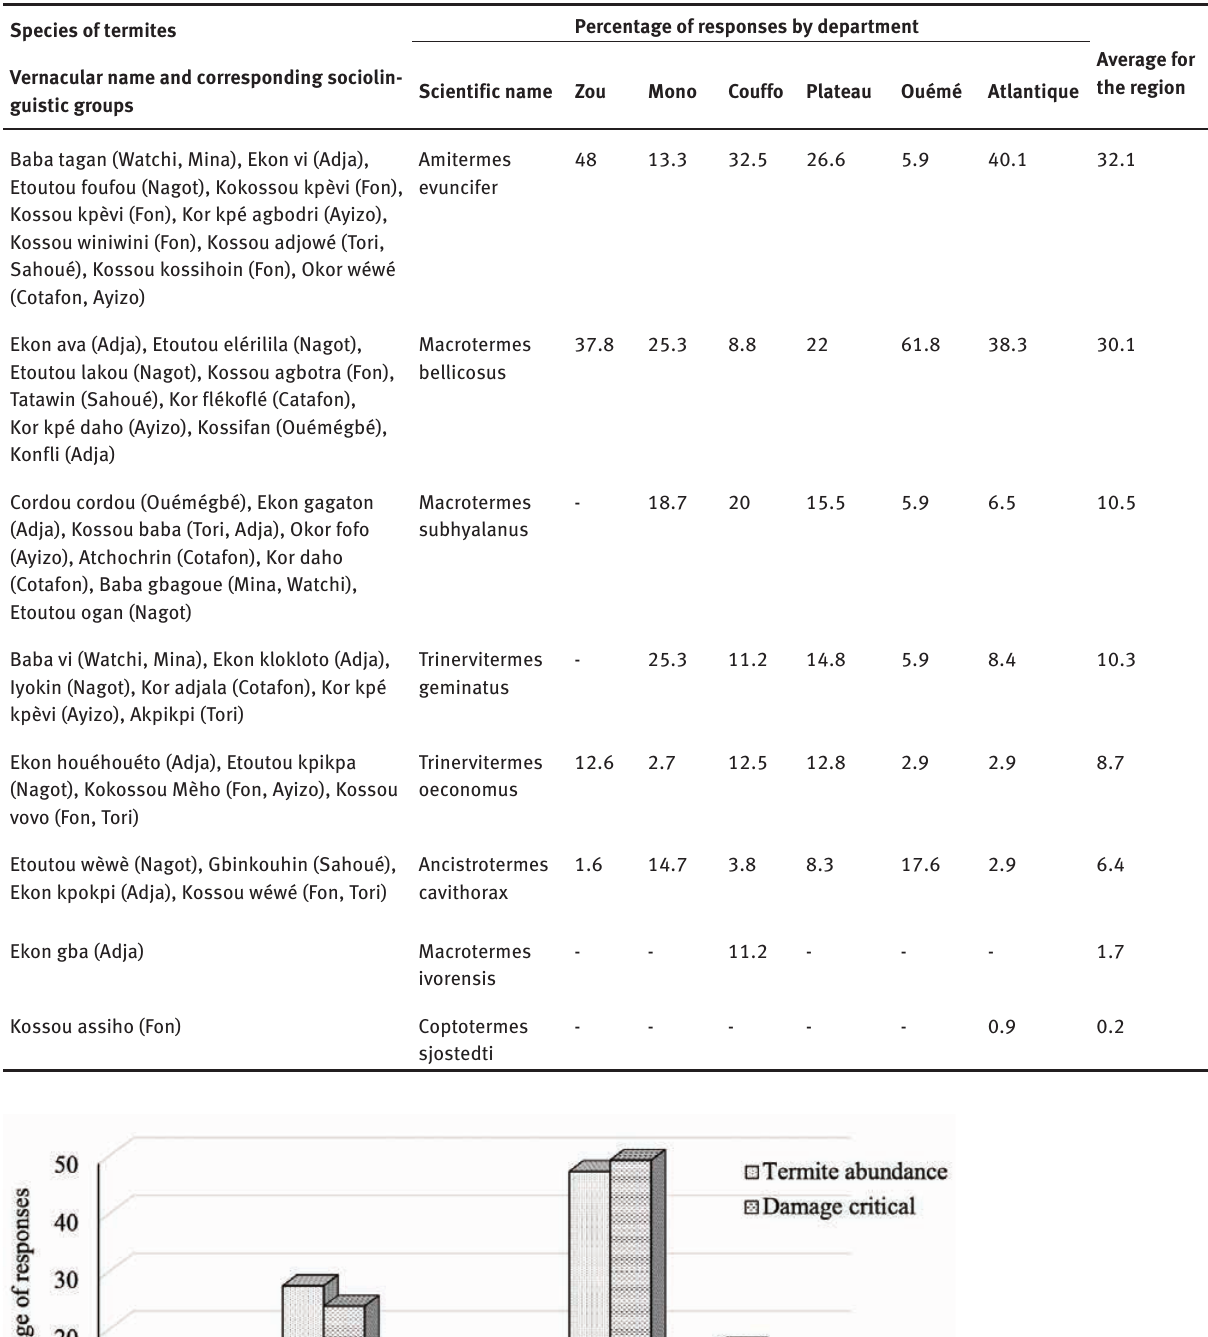
Average for the regionVernacular name and corresponding sociolin-